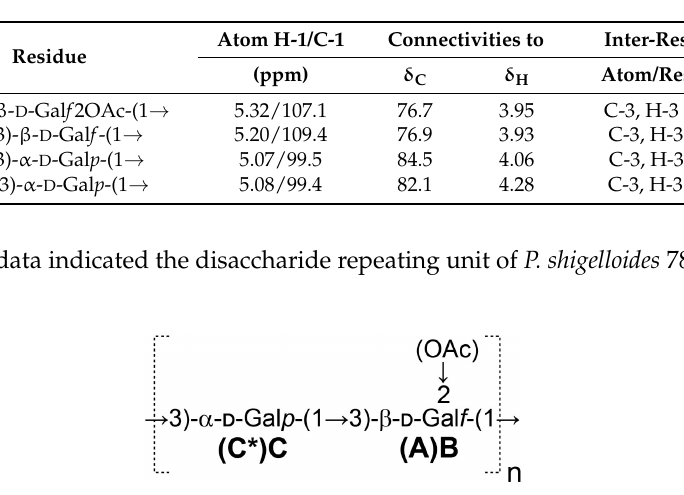
Table 2. Selected inter-residue NOE and 3 J H,C -connectivities from the anomeric atoms of the O- antigen unit of PS P. shigelloides strain CNCTC 78/89.